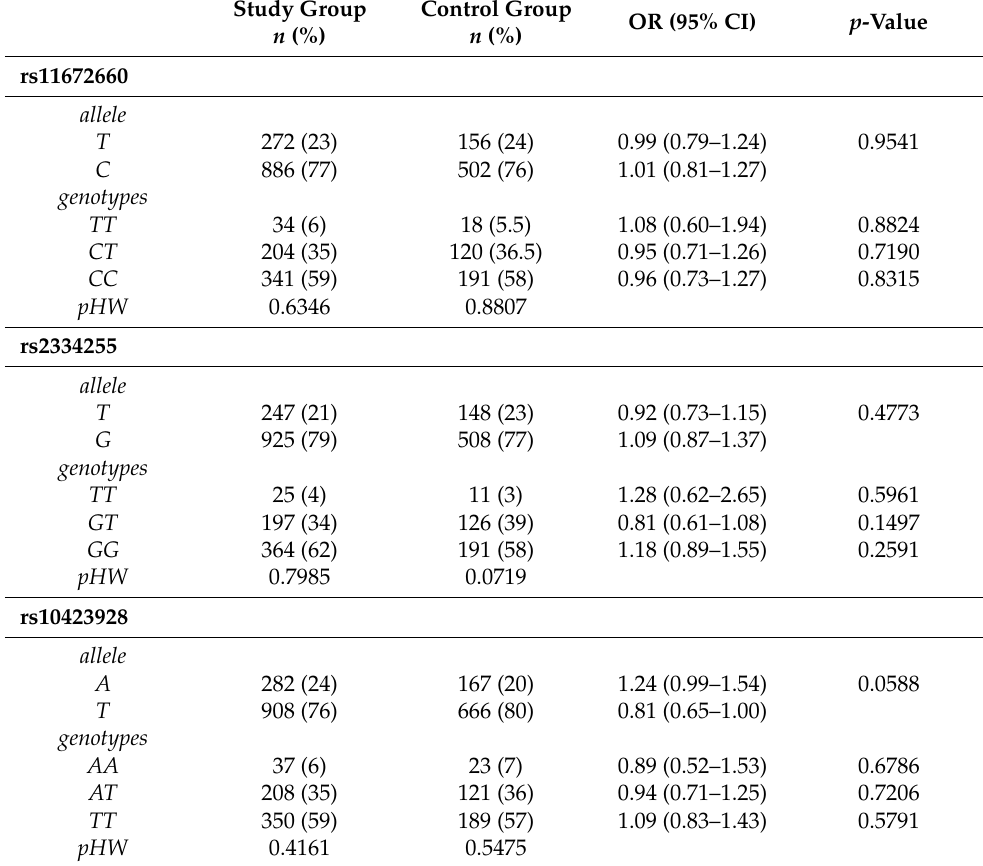
Table 2. The distribution of particular alleles and genotypes in the study and the control group. Study